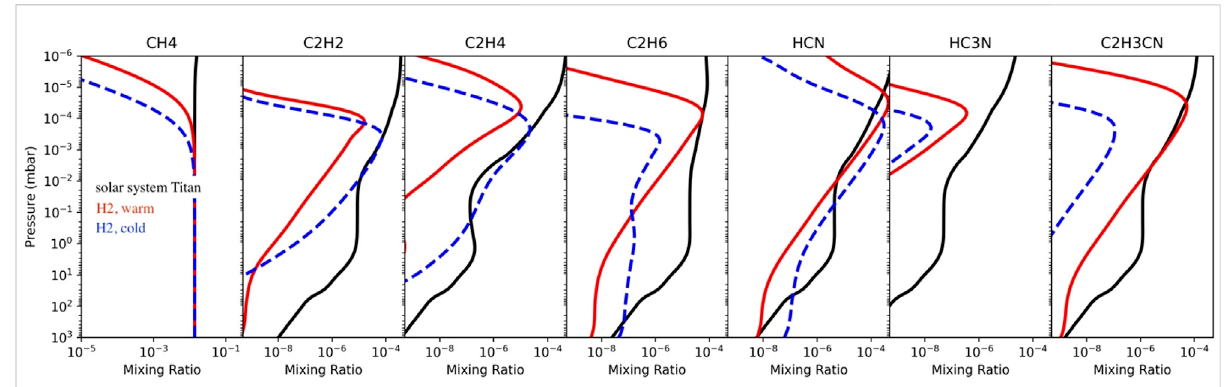
FIGURE 7 Response to temperature and H 2 content; all cases are around a Sun-like star at 9.5 AU. Solid black lines: Titan temperature, N 2 dominated atmosphere; red lines: warm, H 2 dominated atmosphere; blue lines: Titan temperature (cold), H 2 dominated atmosphere. From left to right, the panels show CH 4 , C 2 H 2 , C 2 H 4 , and C 2 H 6